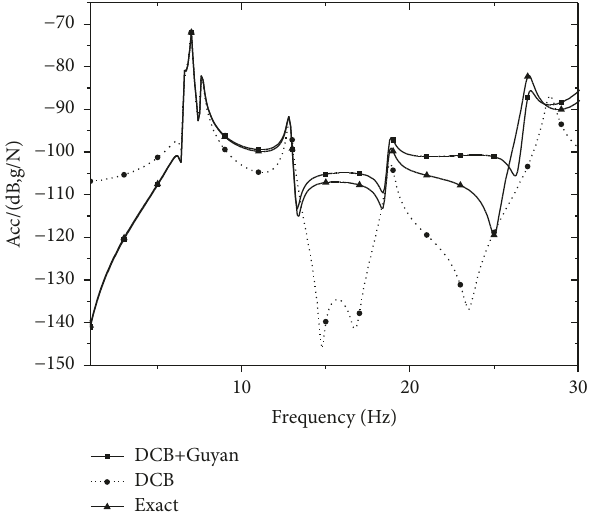
Figure 8: The suspended beam and its mesh model.